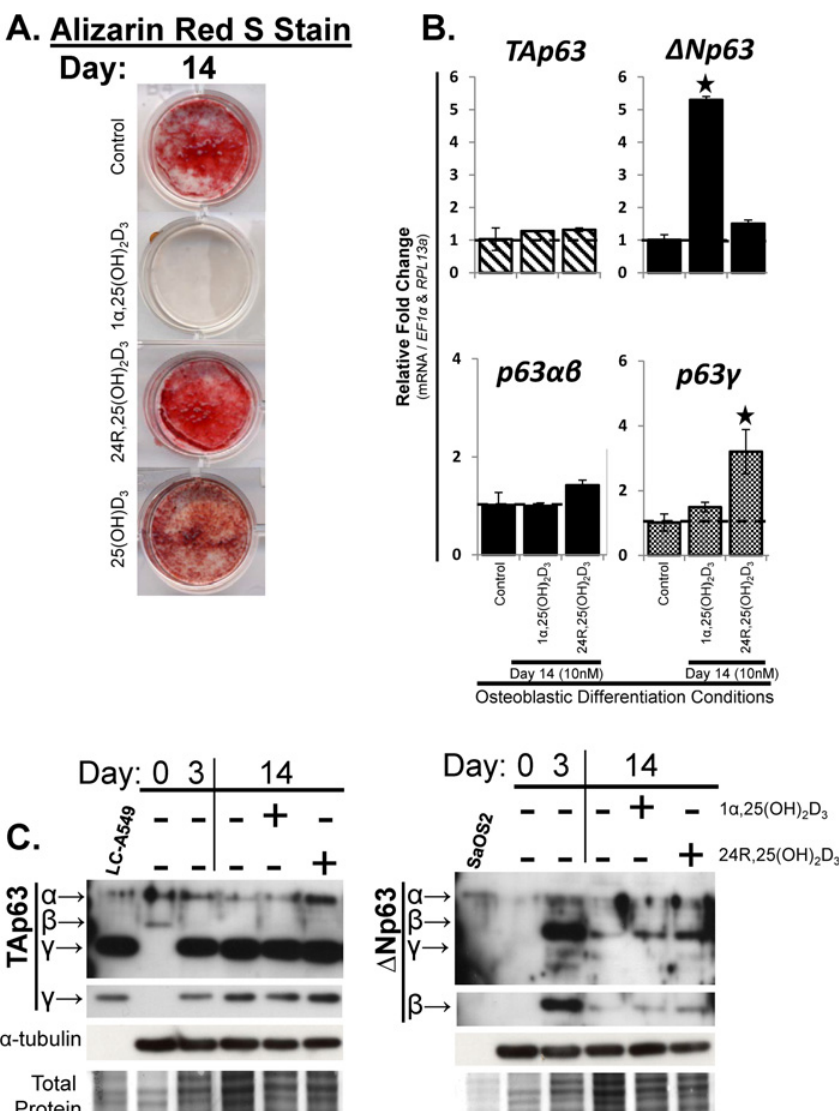
Fig 4. TAp63 γ and Δ Np63 β are the predominant p63 variants during osteoblastic differentiation of hMSC. hMSC were seeded at 10,000 cells/cm 2 under expansion conditions overnight then switched to osteoblastic differentiation conditions, without dexamethasone (Day 0). hMSC were treated with vitamin D 3 metabolites 1 α ,25(OH) 2 D 3 or 24R,25(OH) 2 D 3 (10nM), or the vitamin D 3 pro-hormone 25-hydroxyvitamin D 3 (25(OH)D 3 ) (10nM), starting at Day 0, and then re-treated every 3 days with media changes through Day 14. Control groups had no vitamin D 3 treatments. Cells were fixed or harvested for RNA and protein at Days 3 and 14. A) Alizarin Red-S stain was used to determine Ca 2+ mineralization. B) RT-qPCR analysis of p63 isoform (top panels, TA- and Δ Np63 ) and splice variant mRNA (bottom panels, p63 α / β and p63 γ ) expression. C) Western blot analysis of p63 isoforms using antibodies detecting TAp63 variants (left panel, TAp63 α , β , γ ) or Δ Np63 variants (right panel, Δ Np63 α , β , γ ) during expansion conditions (Day 0) and under osteoblastic differentiation conditions (Days 3 and 14). Coomassie Blue = Total protein. Positive controls: TAp63: LC-A549 cells (positive for TAp63 γ and low-expression of TAp63 α protein) and Δ Np63; SaOS2 cells (positive for Δ Np63 variants). N = 3 independent experiments in triplicate. ( * ) p (cid:1) 0.05 compared to control (expanded, untreated hMSC). hMSC used were from a 7 and 22 year old